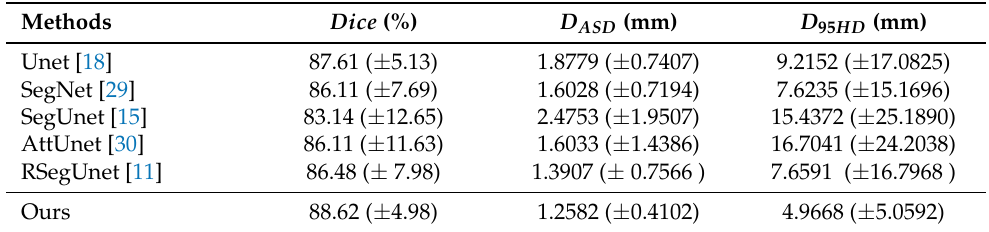
Table 2. Quantitative comparison of segmentation performance for the CT dataset between the proposed method and the state-of-the-art